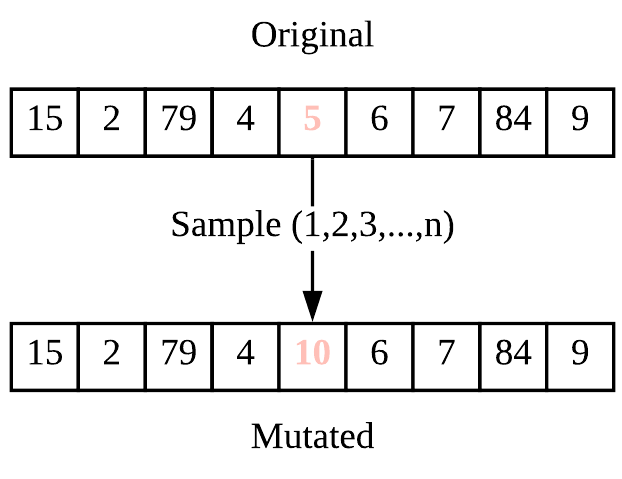
Figure 5. Uniform mutation